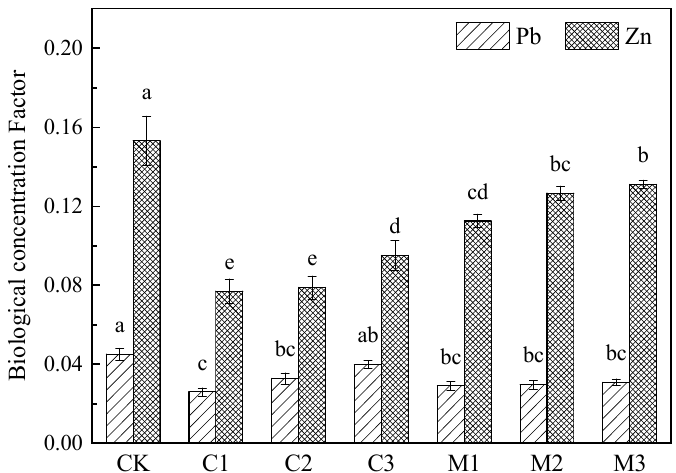
Figure 5. Biological concentration factor of Nerium indicum under improved treatment.